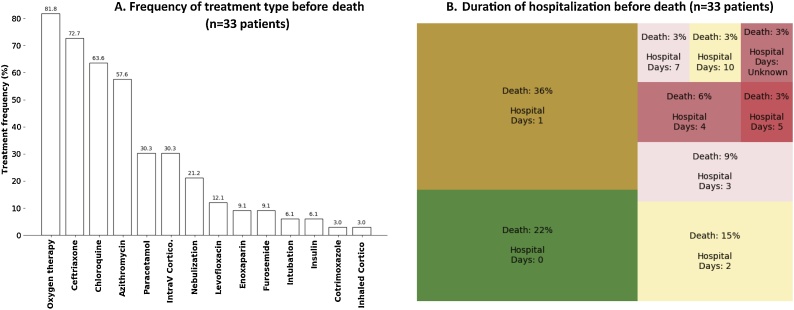
(A) Frequency of treatment type. (B) Length of hospital stay for 33 COVID-19 cases seeking care at CHU de Tengandogo before death in Burkina Faso.